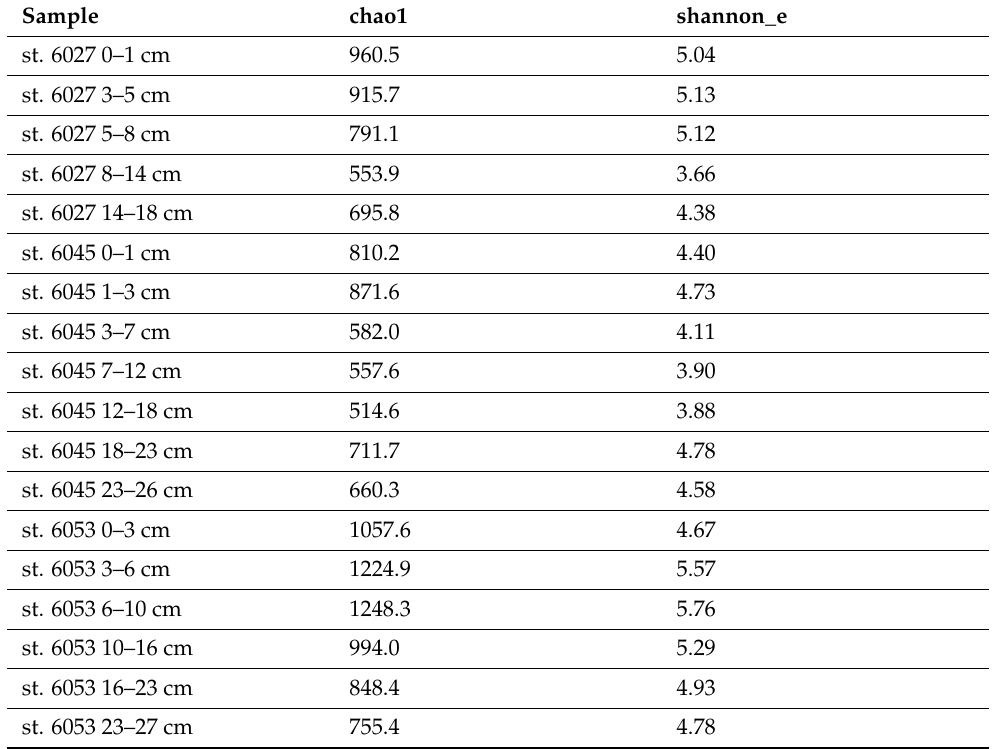
Table 2. Alpha diversity indices in the sediment samples from stations 6027, 6045, and